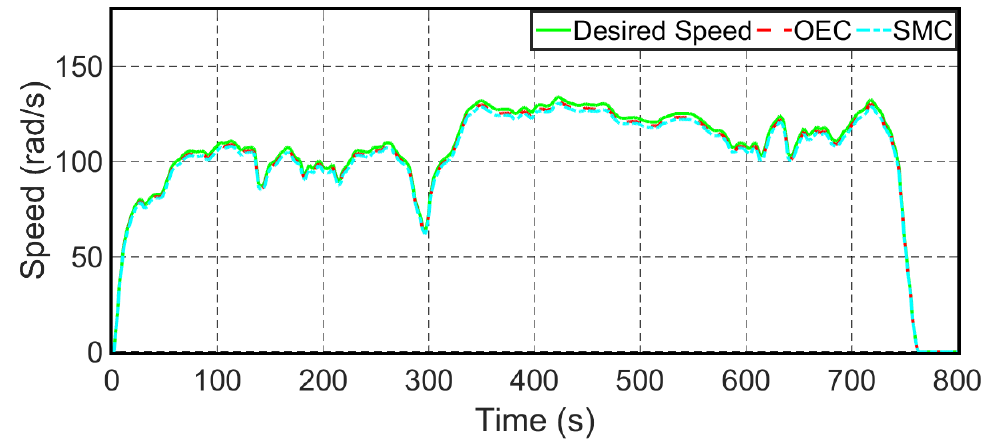
Figure 11. Experimental analysis: HWFET-based analysis at 60 ◦ C.